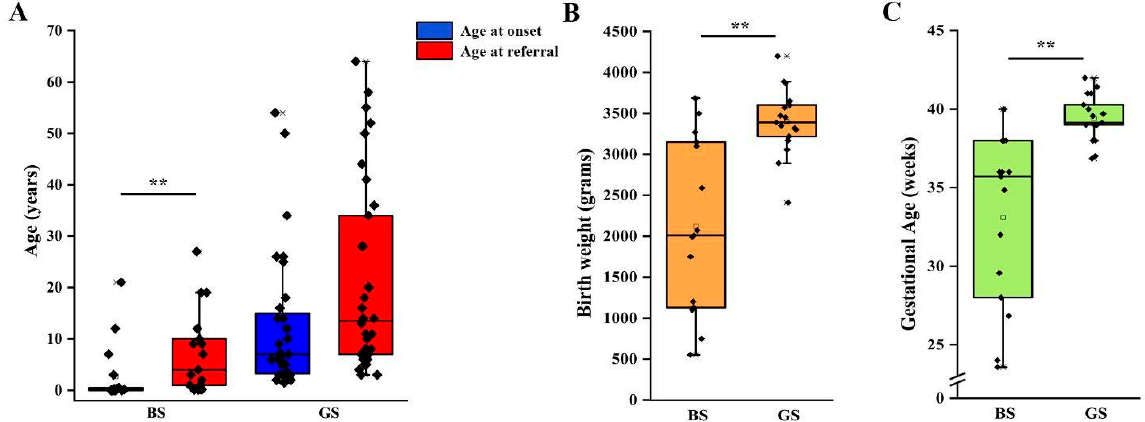
Figure 2. Clinical features of patients according to genetic diagnosis. ( A ) Age at onset and age at referral for genetic testing in patients with a molecular diagnosis of BS and GS. ( B ) Birth weight in patients with a molecular diagnosis of BS and GS. ( C ) Gestational age at birth in patients with a molecular diagnosis of BS and GS. Individual scores are shown as ▪ . ** p value < 0.001. GS, Gitelman syndrome; BS, Bartter syndrome.